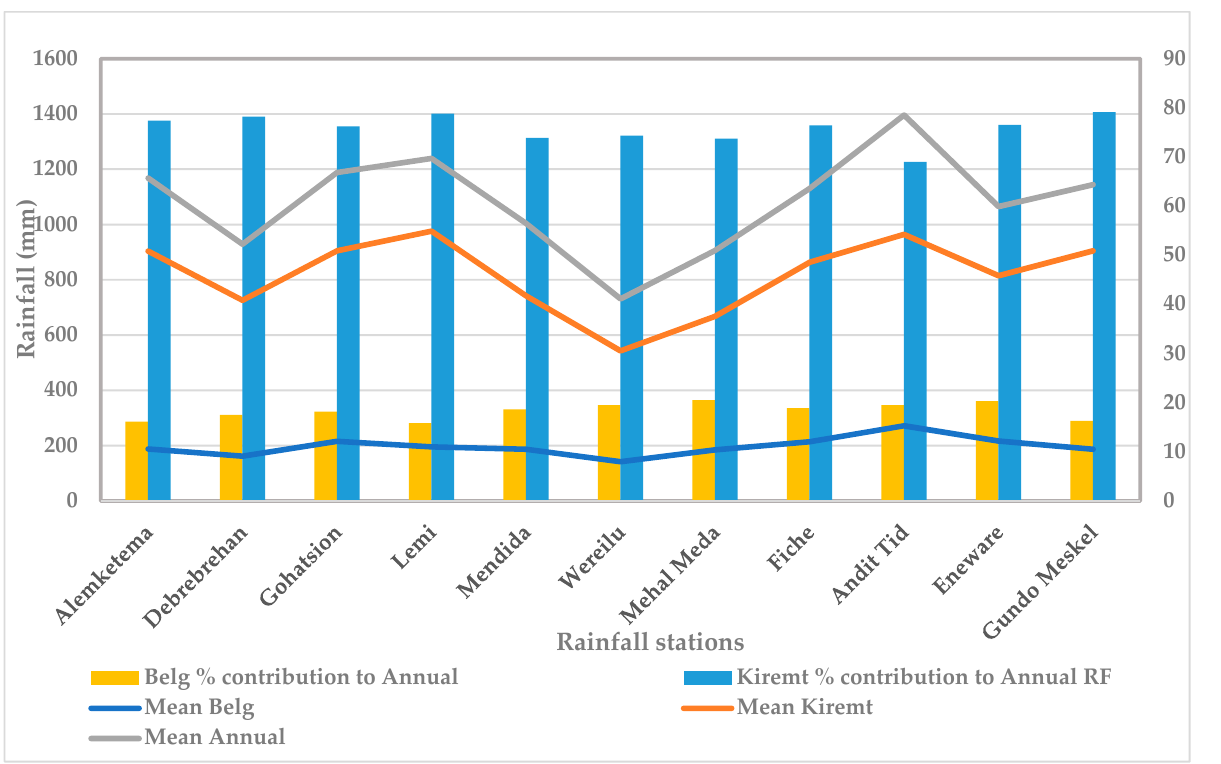
Figure 5. Belg and Kiremt seasonal rainfall contributions to the annual totals.